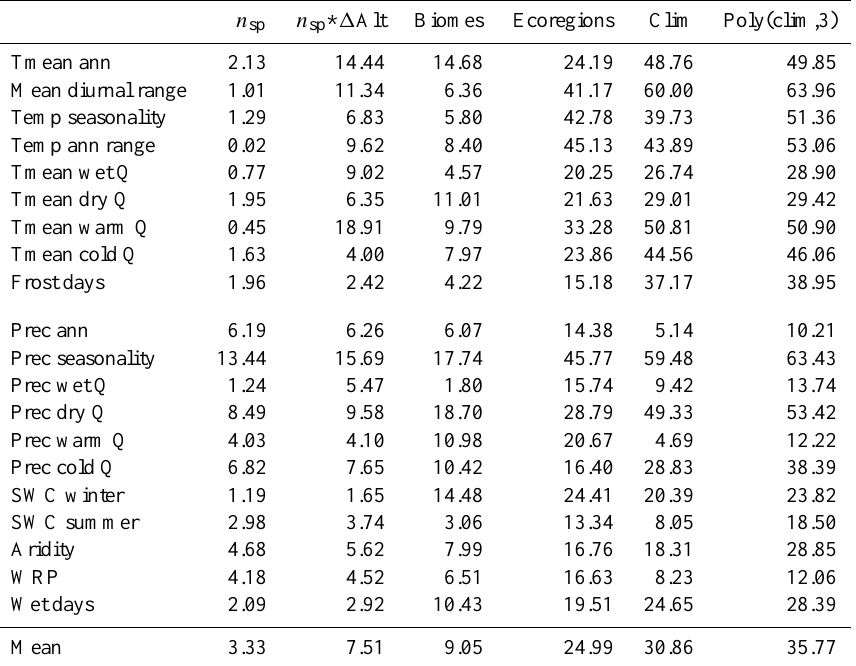
Table 3. Percentages of variance ( R 2 ) explained for the three different hypotheses we tested in this study to describe the distribution of δ v (s) , namely the impact of (1) the number of species ( n sp and n sp * (cid:49) Alt), (2) the type of vegetation (biomes and ecoregions) and (3) the expected climatic value (clim and poly(clim,